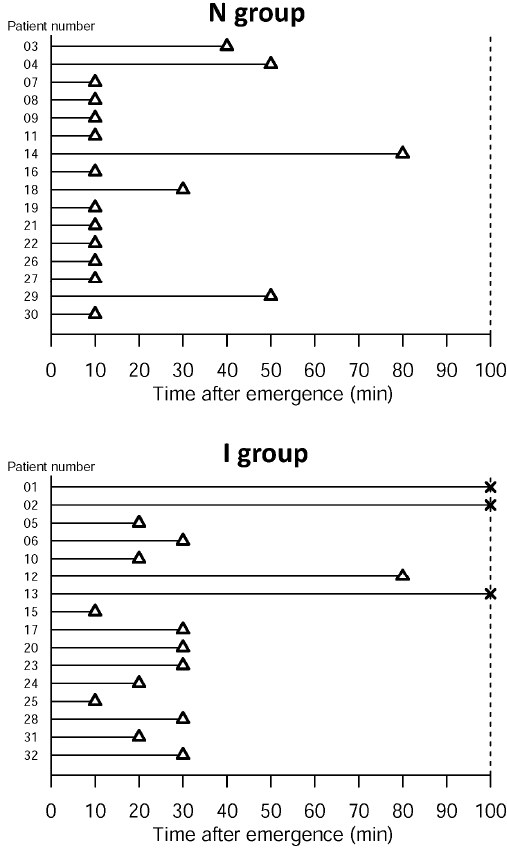
Figure 5. Time to successful esophageal emptying after emergence for both groups. Time to the first presentation of successful bolus transmission (BT) through the lower esophageal sphincter based on individual high-resolution impedance manometry (HRIM) measurements. N: non-intubated video-assisted thoracoscopic surgery group; I: intubated video-assisted thoracoscopic surgery group. Measurement: HRIM was performed every 10 min, up to 10 times for each patient. Note: ∆ : the first successful BT; ╳ : the patient presented no successful BT within 10 measurements.